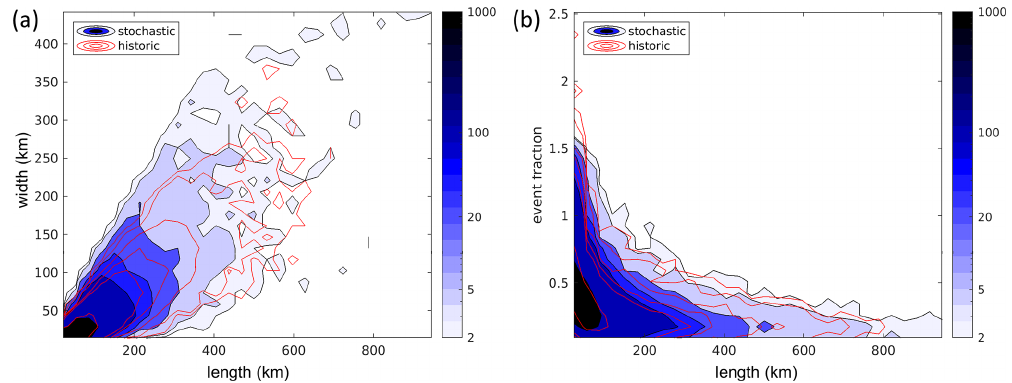
Figure 12. Scatterplot of historic and stochastic event properties: (a) length and width and (b) length and fraction of event covered by potential hail events.